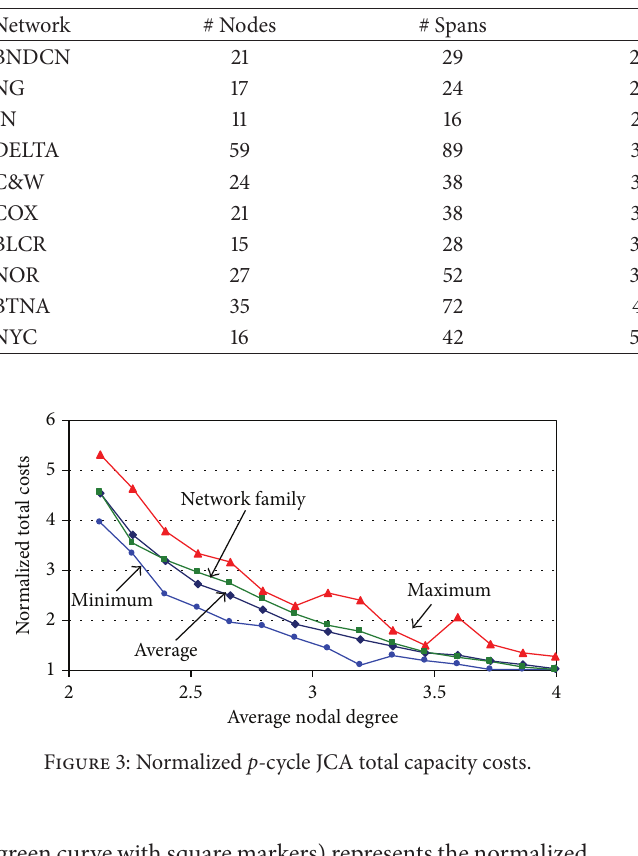
(green curve with square markers) represents the normalized total working plus spare capacity costs for the member of the family with the indicated average nodal degree. The three other curves correspond to the aggregated results from the 300 pseudorandom networks. Each data point on the dark blue curve with diamond markers represents the mean normalized total capacity averaged over all random networks with the indicated average nodal degree. Each data point on the light blue curve with circular markers represents the min- at the indicated average nodal degree, and each data point on the red curve with triangle markers represents the maximum